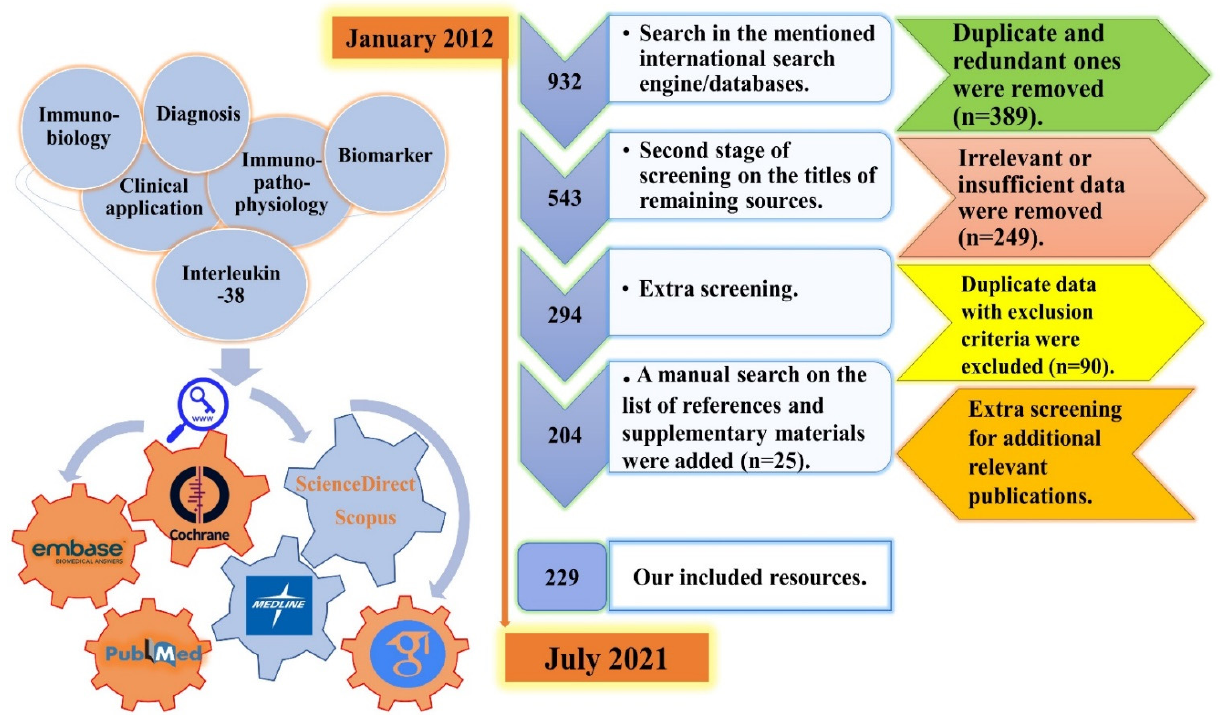
Figure 2. Search strategy according to the PRISMA guideline (PRISMA-P extension 2020 statement). Created by Esmaeilzadeh et al.